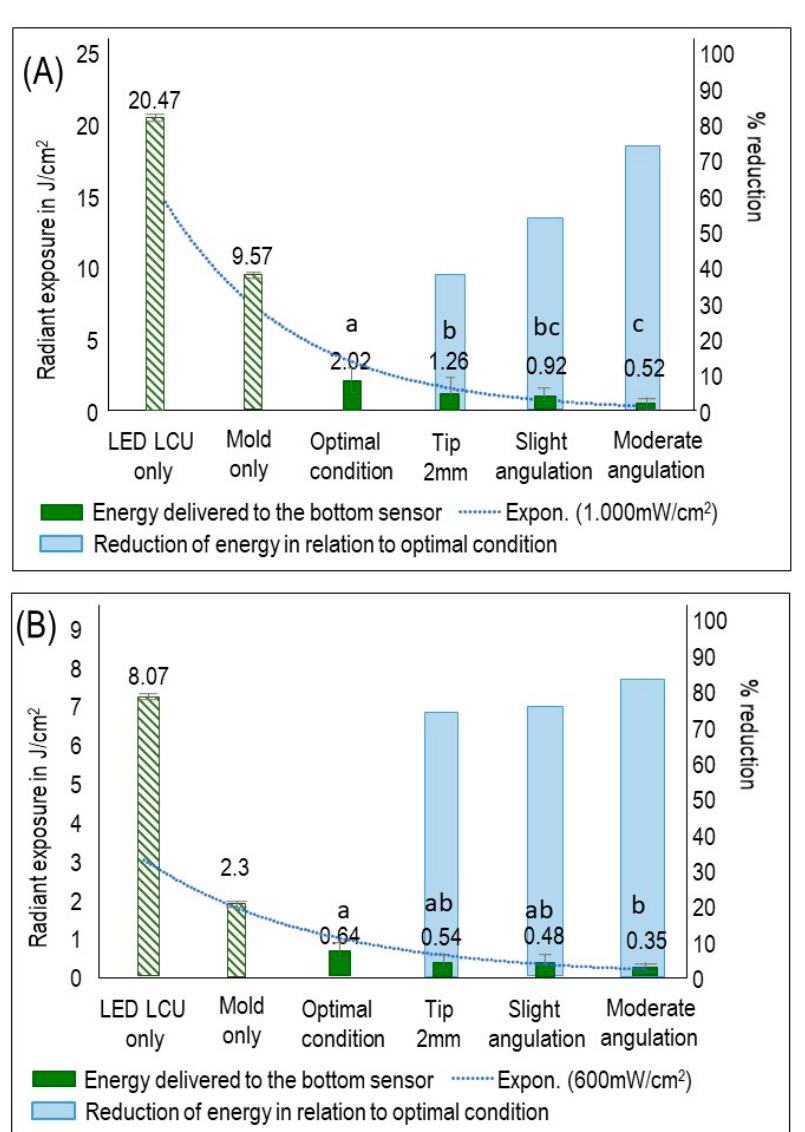
Figure 2. R E values that reached the sensor and the percentage of R E reduction in the underperformed conditions compared to optimal condition (mean ± sd; n = 6). ( A ) R E values and the percentage of R E reduction using LCU 1000 with an output of 1000 mW/cm 2 . ( B ) R E values and the percentage of R E reduction using LCU 600 with an output of 600 mW/cm 2 . On the first y -axis, the barplot demonstrates radiant exposure (R E ) expressed in J/cm 2 . On the second y -axis, the barplot demonstrates the percentage of R E reduction. The dotted line illustrates the reduced R E for all groups concerning R E delivered to the sensor by applying the LCU directly on the sensor. Values with different letters are significantly different from each other ( p <